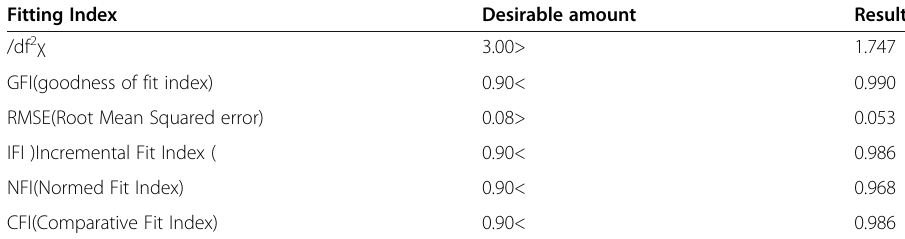
Table 5 Goodness of fit index (GFI) for the proficiency Model